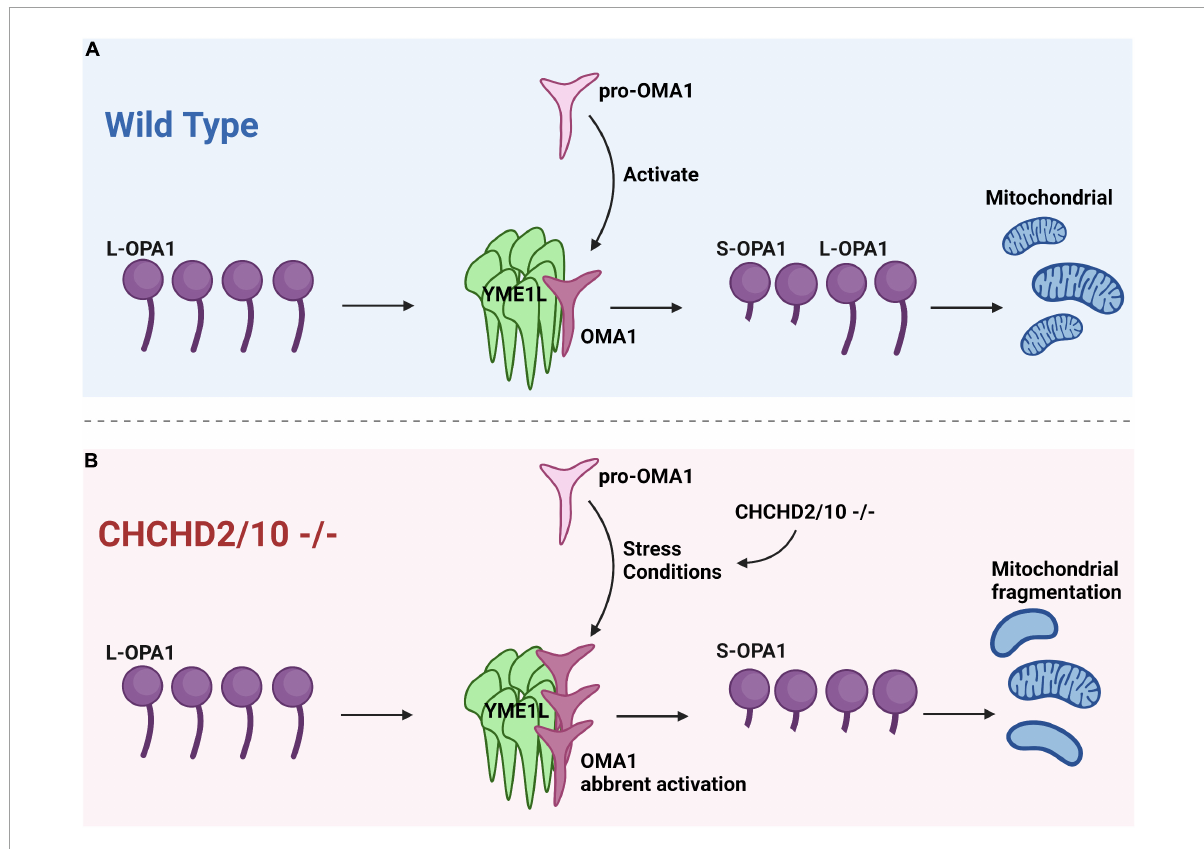
FIGURE2 Cristae anomalies in CHCHD2/CHCHD10 linked to OPA1 processing by OMA1 activation. (A) Under normal conditions, when pro-OMA1 is activated, OMA1 binds to YME1L, resulting in the cleavage of L-OPA1 into S-OPA1 and the initiation of mitochondrial fission. Under normal conditions, L-OPA1 and S-OPA1 are in equilibrium, maintaining a balanced state of fission and fusion in mitochondria. (B) CHCHD2/10 deletion can result in excessive activation of pro-OMA1 and increased binding of OMA1 to YME1L, leading to mitochondrial